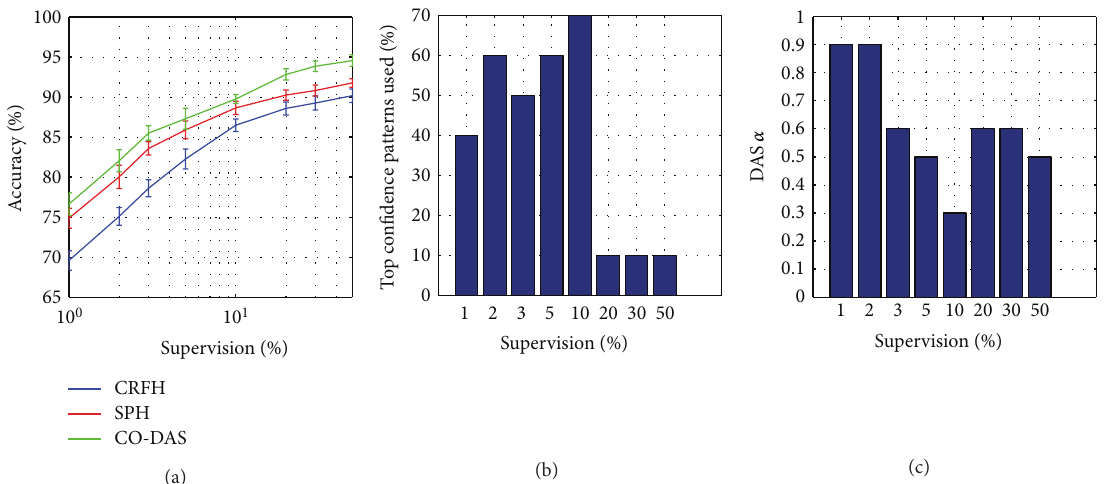
Figure 9: Effect of supervision level on the CO-DAS performance and optimal parameters. (a) Accuracy for CO-DAS and single feature approaches. (b) Optimal amount of selected samples for the Co-Training feedback loop. (c) Selected DAS 𝛼 parameter for late fusion. (IDOL2 dataset, random setup).